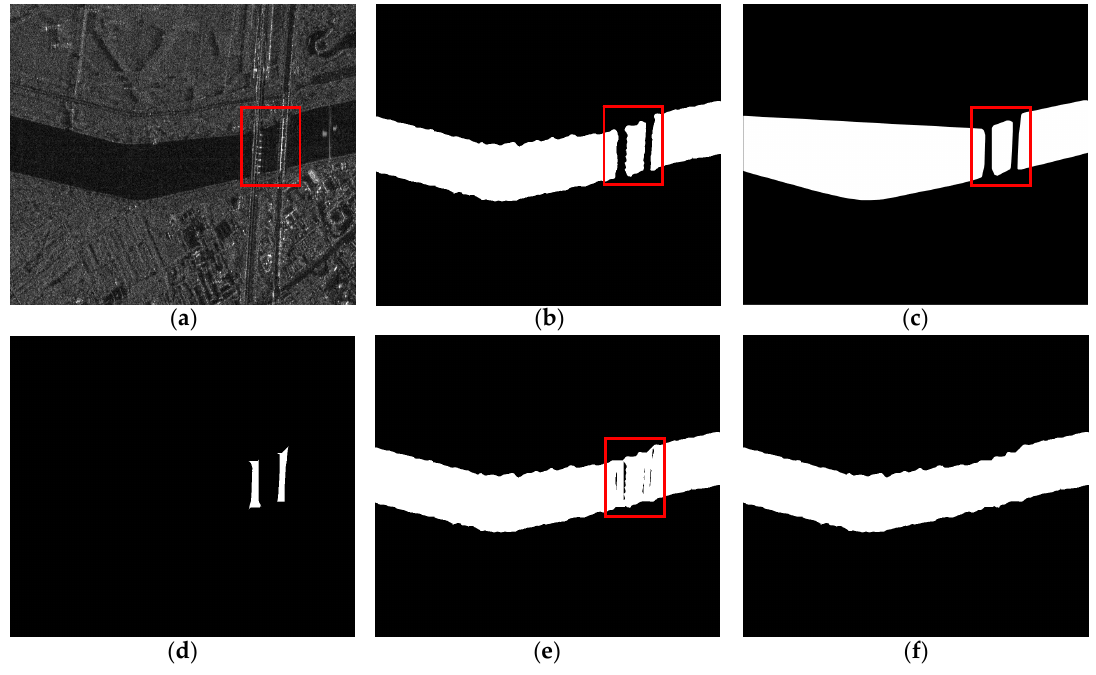
Figure 14. Example of the limitation of the minimum convex hull. ( a ) Original image. ( b ) Extracted riverway segments. ( c ) Constructed convex hulls. ( d ) Regions of growth. ( e ) Riverway with discontinuity connection. ( f ) Optimization of riverway